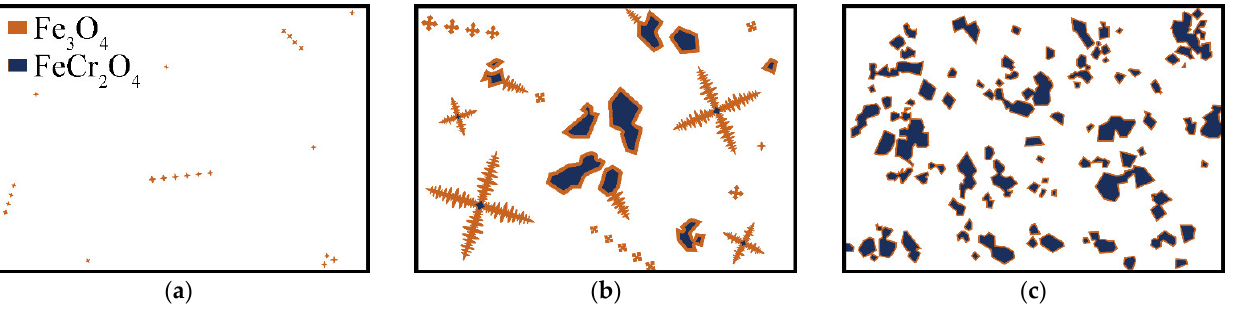
Figure 9. Crystallization mechanism of spinel in CaO-SiO 2 -Fe t O system at 1500 °C: ( a ) 0 wt% Cr 2 O 3 ; ( b ) 0.99–4.76 wt% Cr 2 O 3 ; ( c ) 6.54–9.09 wt% Cr 2 O 3